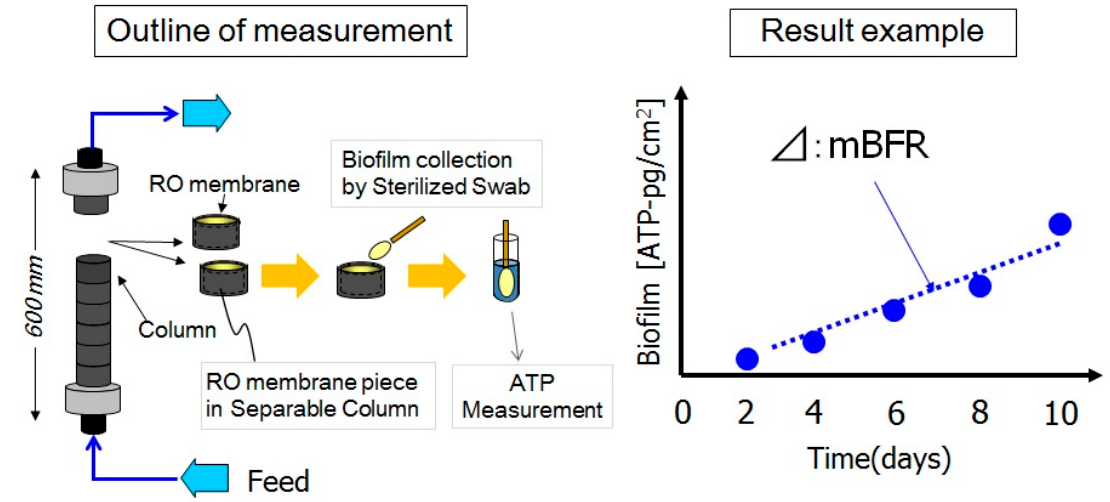
Figure 6. Method of measuring mBFR (Membrane Biofilm Formation Rate).